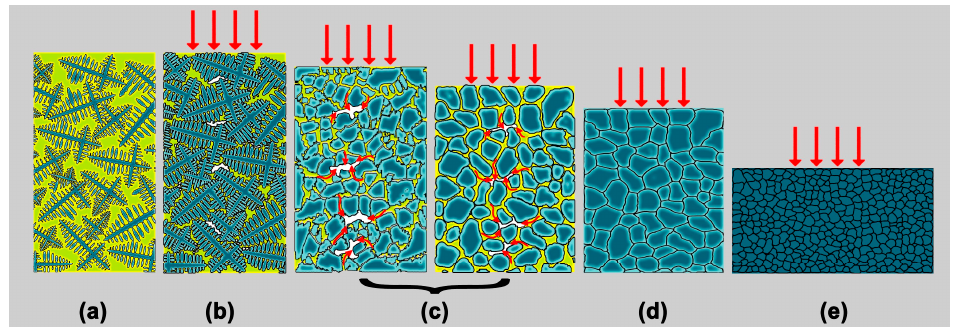
Figure 9. Schematic diagram of mechanism in eliminating coarse dendrite structures and shrinkage porosity in the study (The white regions in b and c represent shrinkage porosity, the yellow regions in a, b, and c represent liquid). ( a ) The initial dendrites grew during the solidification and continued discharging solute elements (such as Cr, Mo, and V) to the melt; ( b ) at the end of solidification, the dendrites formed a cohesive network. The reason is due to the insufficient feeding in the interdendritic region, shrinkage porosity defects formed. In this case, the 0.1/s, 50% LDP was implemented; ( c ) Under the large strain induced by the large deformation, the primary dendrites were fully broken to large amounts of sub-grains with high-solute liquid surrounded (Figures 5e,f and 6). The residual liquid between the interdendritic regions were released and could flow freely, which plays a role of forced feeding by the external deformation (red arrow in c). Due to these reasons, the coarse dendrites structure and shrinkage porosity defects were eliminated. The sub-grains gradually grew and spheroidized during the process; ( d , e ) the microstructure was refined due to recrystallization in the subsequent deformation.